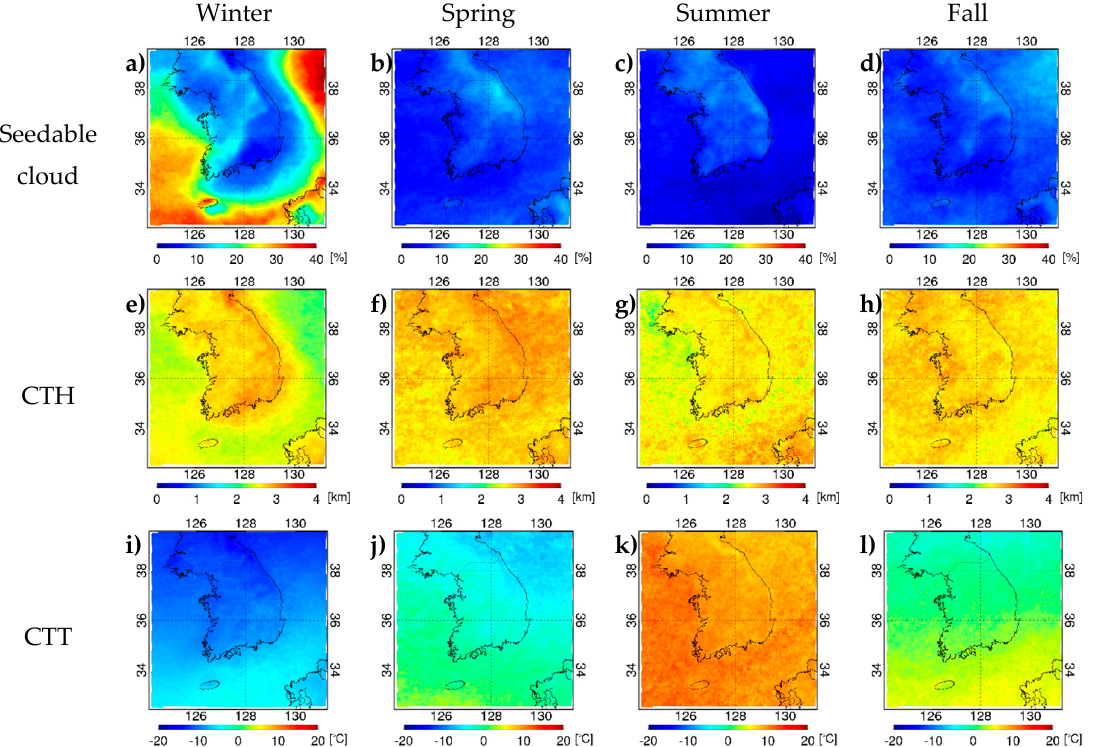
Figure 3. Frequency distribution of seedable clouds (both water cloud phase and ice cloud phase (a) - d) ) and cloud characteristics (CTH: e ) -h ), CTT: i ) -l )) by season around the Korean Peninsula. ( a – d ) and cloud characteristics (CTH: ( e – h )), (CTT: ( i – l )) by season around the Korean